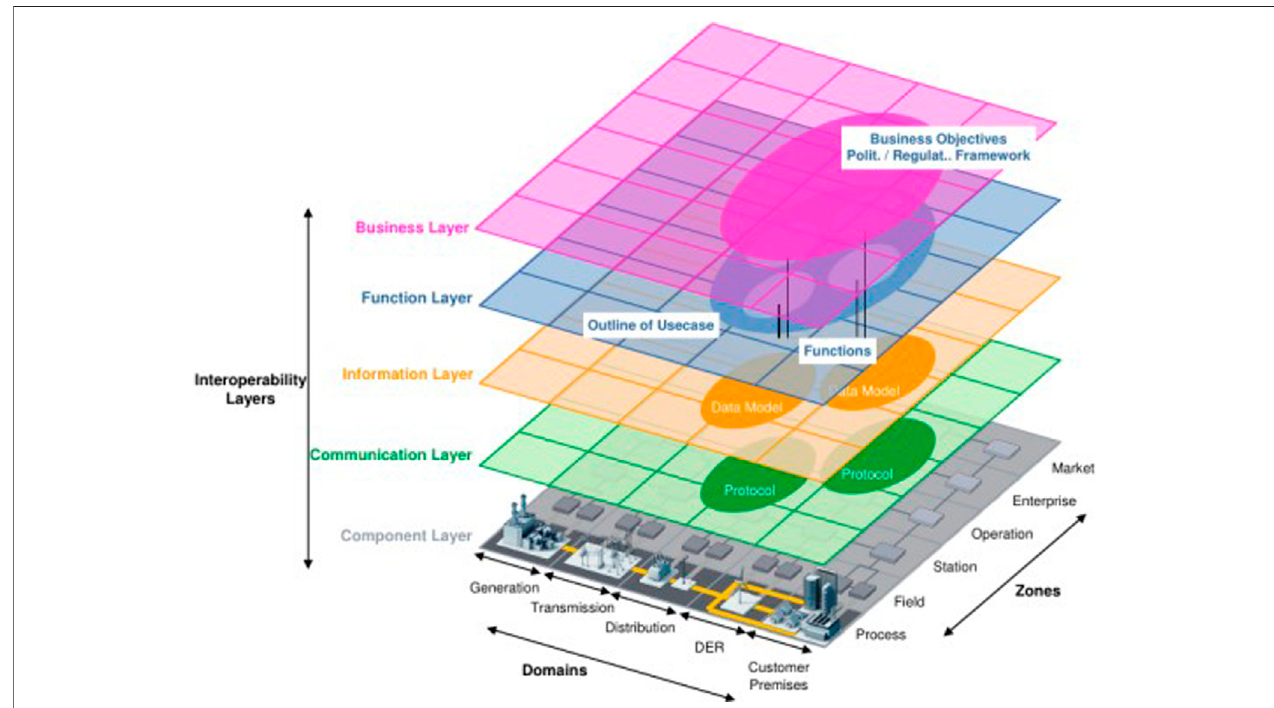
FIGURE 1 | SGAM architecture CEN-CENELEC-ETSI